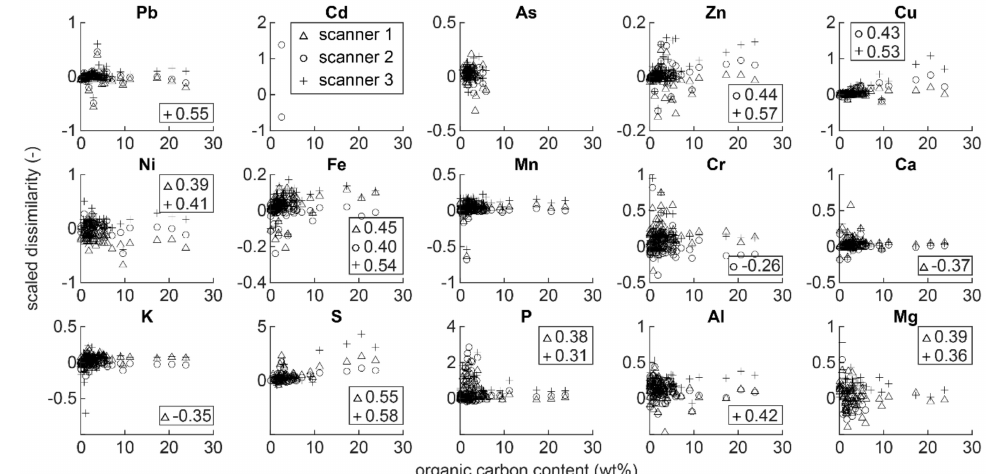
Figure 6. E ff ect of organic carbon (OC) on X-ray fluorescence (XRF) performance. Scatterplots of the scaled dissimilarities for all samples and all scanners versus the samples’ OC contents. Significant (5% significance level) Spearman correlations between the scaled dissimilarities and the OC contents are shown for each